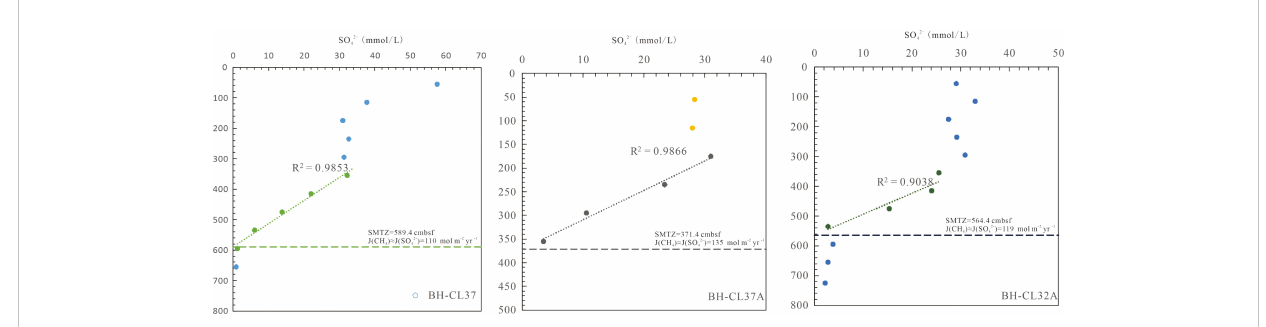
FIGURE 4 Estimated SMTZ depth and methane diffusion fl ux for BH-CL37, BH-CL37A and BH-CL32A